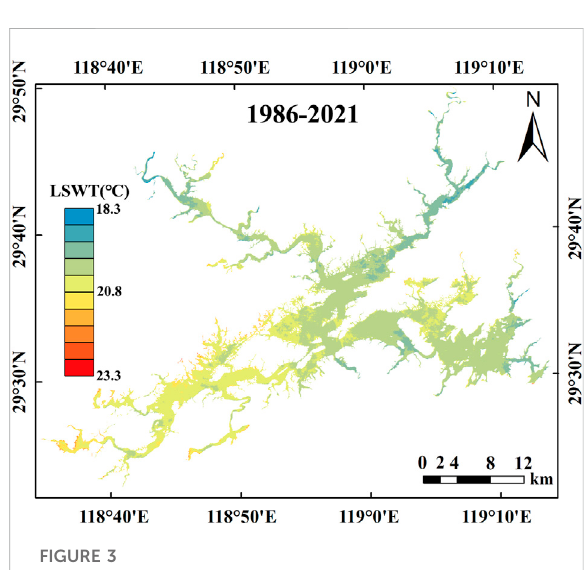
FIGURE 3 36-year (1986 – 2021) averaged LSWTs in Lake